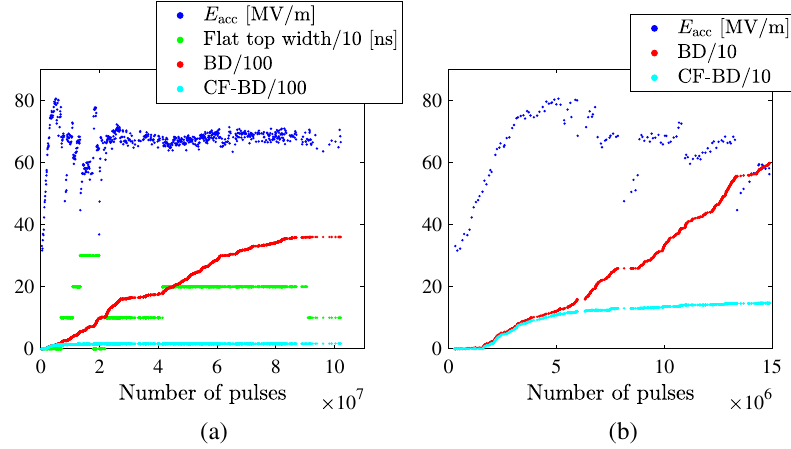
FIG. 16. Summary of the conditioning history of THU-CHK-#2. (a) Full history. The blue dots denote E denote flat top pulse width [ns] divided by 10, the red dots denote total breakdown number divided by 100, and the cyan dots denote number of CF-BDs divided by 100. (b) History of the first 1 . 5 × 10 7 pulses. The blue dots denote E breakdown number divided by 10, and the cyan dots denote number of CF-BDs divided by